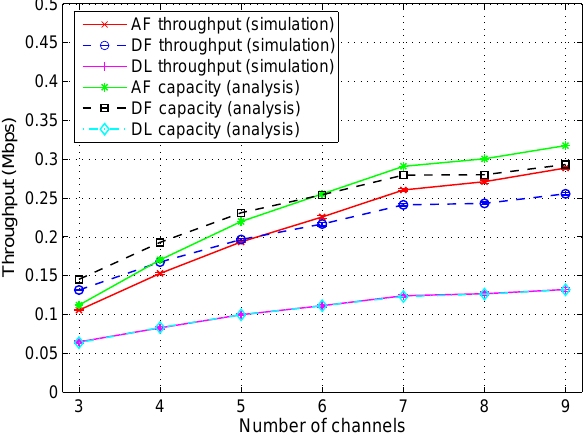
Figure 5. Throughput performance versus number of licensed channels.